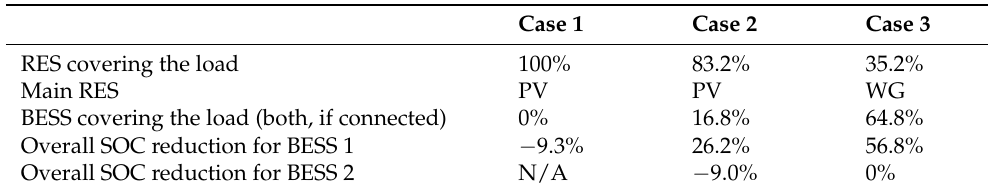
Table 3 . Main results from each simulated emergency case.